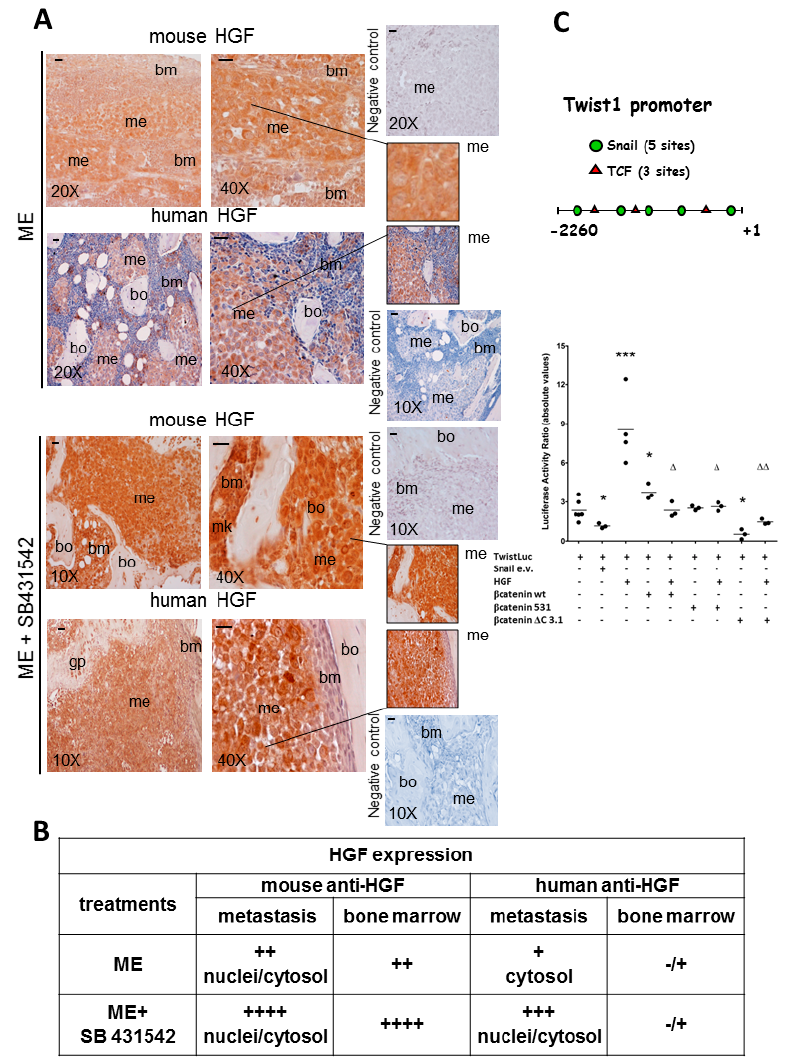
Figure 5. Enhancement of HGF expression in bone metastasis by SB431542: role played by HGF in Twist transactivation and interference of β -catenin. ( A ) Three animals were sacrificed at 25 days for ME, and at 32 days for ME+SB431542, and we show representative images for HGF immunostaining of bone slides from mouse 1, using anti-mouse and anti-human antibodies for HGF; magnifications of details are reported in the insets. gp, growth plate; me, metastasis; bm, bone marrow; mk, megakaryocytes; bo, bone. Negative controls were performed without the specific antibody. Scale bar = 120 μ m. ( B ) In the table we report the semiquantitative evaluation of the degree of positivity of HGF signals at nuclear and cytosol levels for metastasis and bone marrow: the staining intensity with the two antibodies is shown. ( C ) Snail and TCF binding sites in Twist1 promoter are reported. The Twist1 gene reporter was transfected in 1833 cells, and Snail-expression vector co-transfection or HGF treatment was performed. Cells treated or not with HGF were transfected with various β -catenin expression vectors. The data of dot blots show the replicates: starvation ( n = 6), HGF ( n = 4), β -catenin expression vectors ± HGF and Snail expression vector ( n = 3). * P < 0.05, *** P < 0.001 versus basal TwistLuc activity; ∆ P < 0.05, ∆∆ P < 0.005 versus HGF-treated